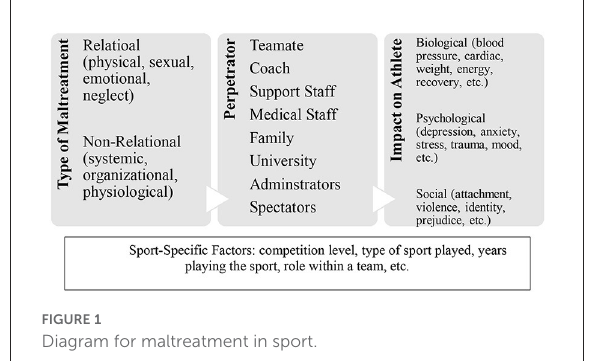
FIGURE1 Diagram for maltreatment in